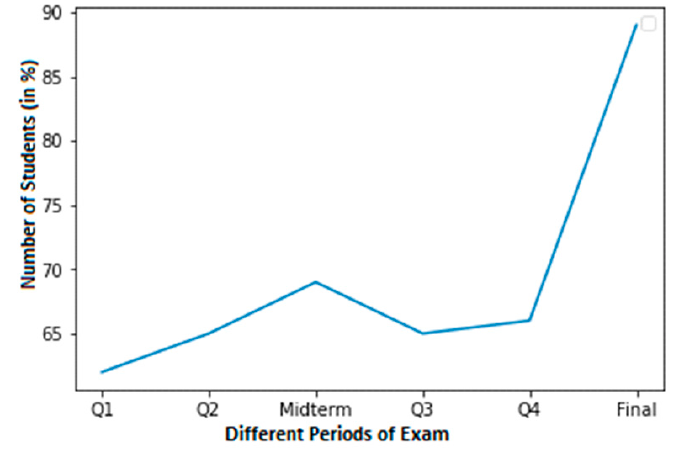
Figure 6. Less cheating increasing grades dataset of students with cheating found.